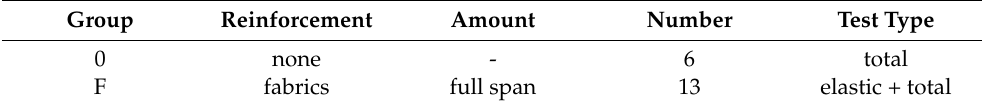
Table 1. Specifications of test groups for